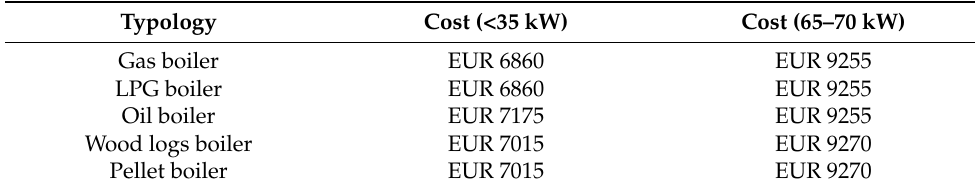
Table 3. Boilers unitary prices considering heater, accessories, and installation cost (excluding VAT)